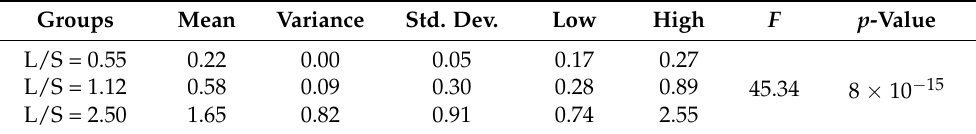
Table 5. ANOVA results of residual ammonia using different L/S ratios.